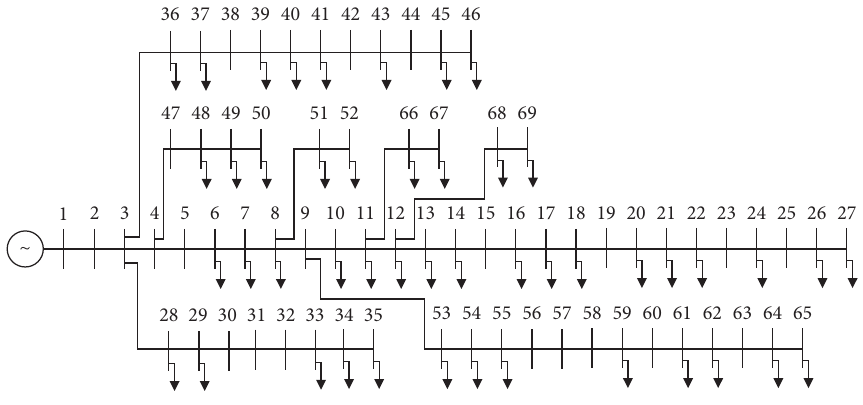
Figure 10: The 69-bus distribution